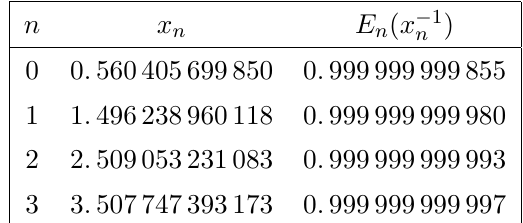
Figure 8 . Numerical calculation of the functions s ((cid:5) p ) ( ~ ) = ~ (top) and s ((cid:5) np ) ( ~ ) = ~ (bottom), as a function of (cid:18) = log( ~ ), by using the TBA equations. Here we set E = 1. (cid:0)